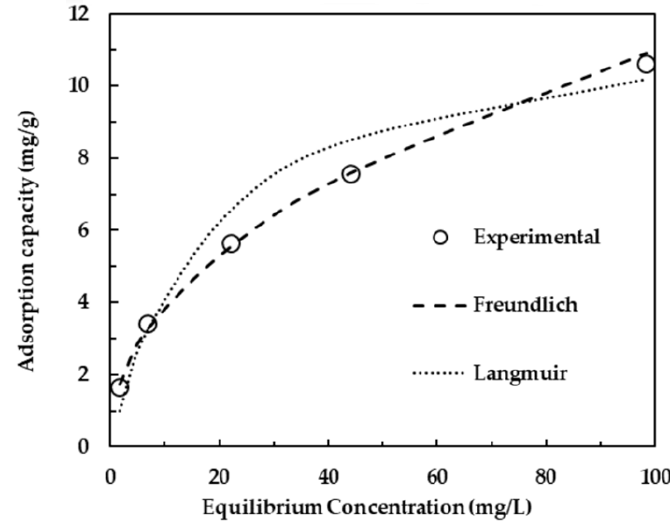
Figure 11. Phenol adsorption onto calcined LDH clay: Langmuir model and Freundlich isotherm